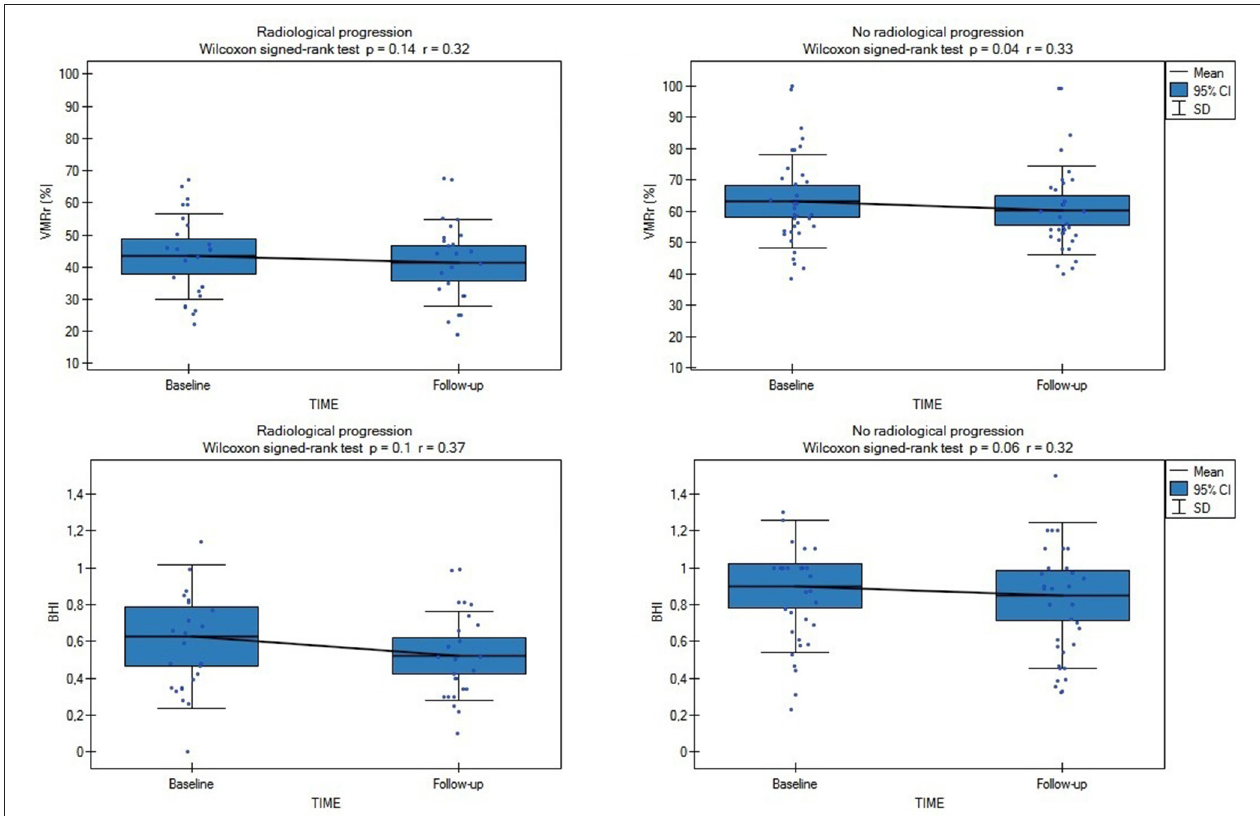
FIGURE 2 | Comparison of baseline and follow-up CVR measures (VMRr and BHI) in SVD subjects with ( n = 25) and without radiological progression ( n = 35). VMRr, vasomotor reactivity reserve; BHI, breath-holding index.